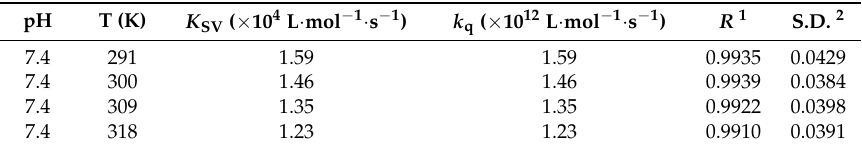
Table 2. Binding constants and thermodynamic parameters from 2-MT/CAT interaction (pH 7.4).